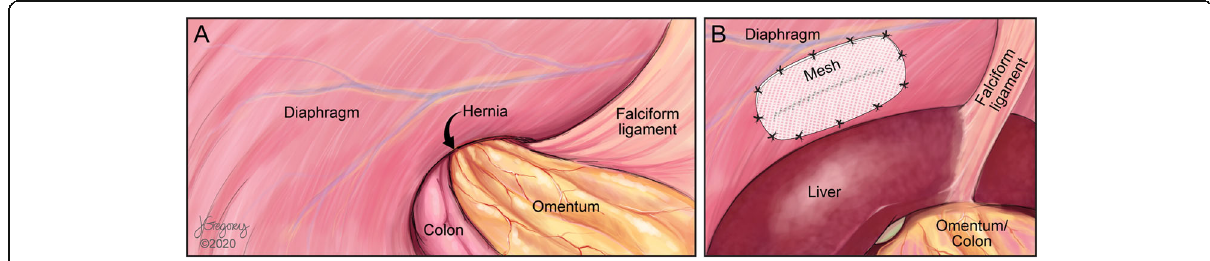
Fig. 5 a Illustration of the initial laparoscopy findings, with the herniation of the abdominal organs through the right diaphragm. Note the absence of the liver in its normal anatomic position. b Illustration of the laparoscopy view at the completion of the procedure with the repaired diaphragm and the Covidien ProGrip® mesh